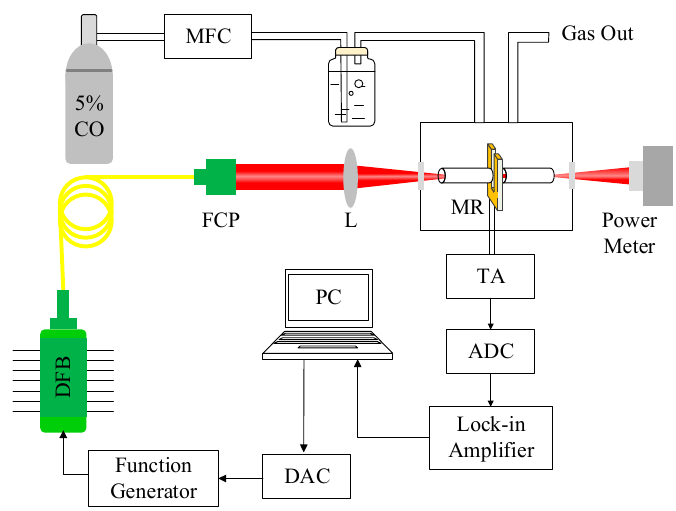
Figure 1. Schematic of a high-power DFB, CW diode laser-based CO-QEPAS sensor platform.